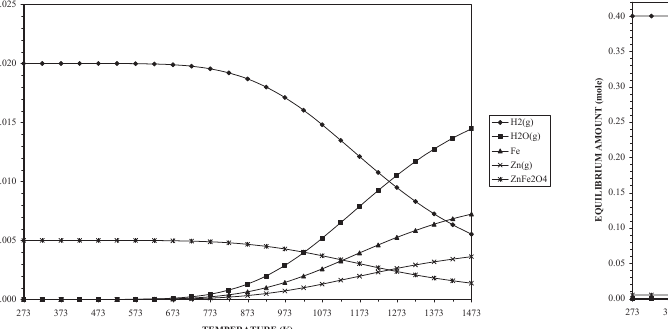
Figure 5. Equilibrium amounts of zinc ferrite with zinc and iron products as a function of temperature in the presence of the stoichimetric amount hydrogen and water vapor.